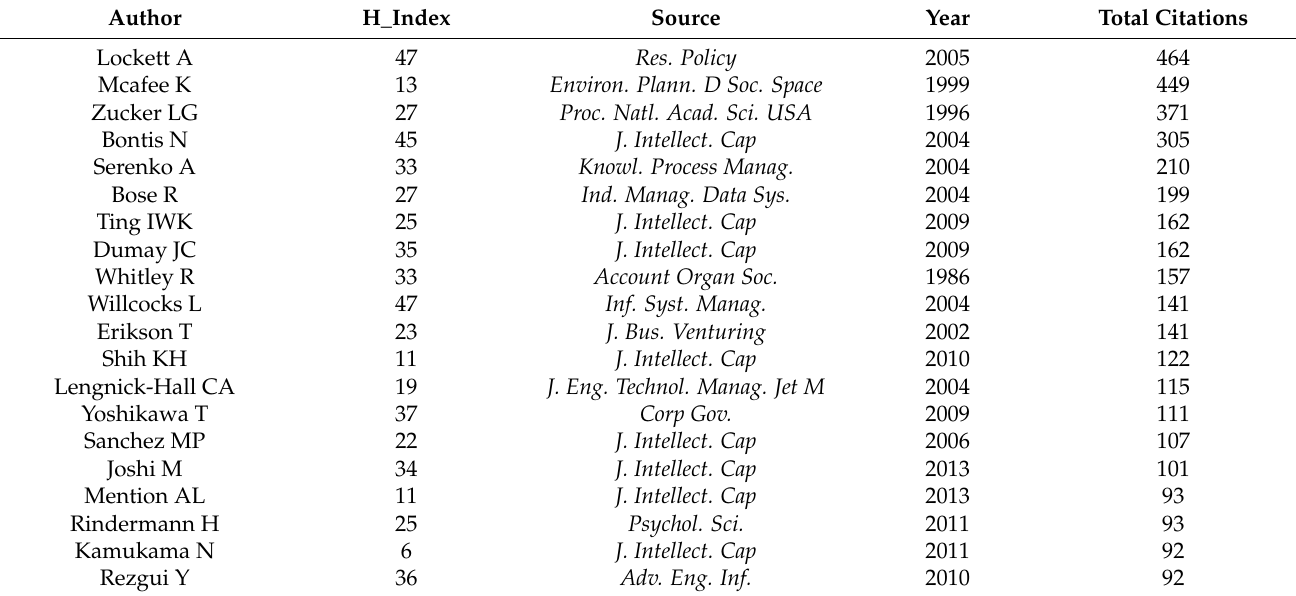
Table 3. Most relevant authors.